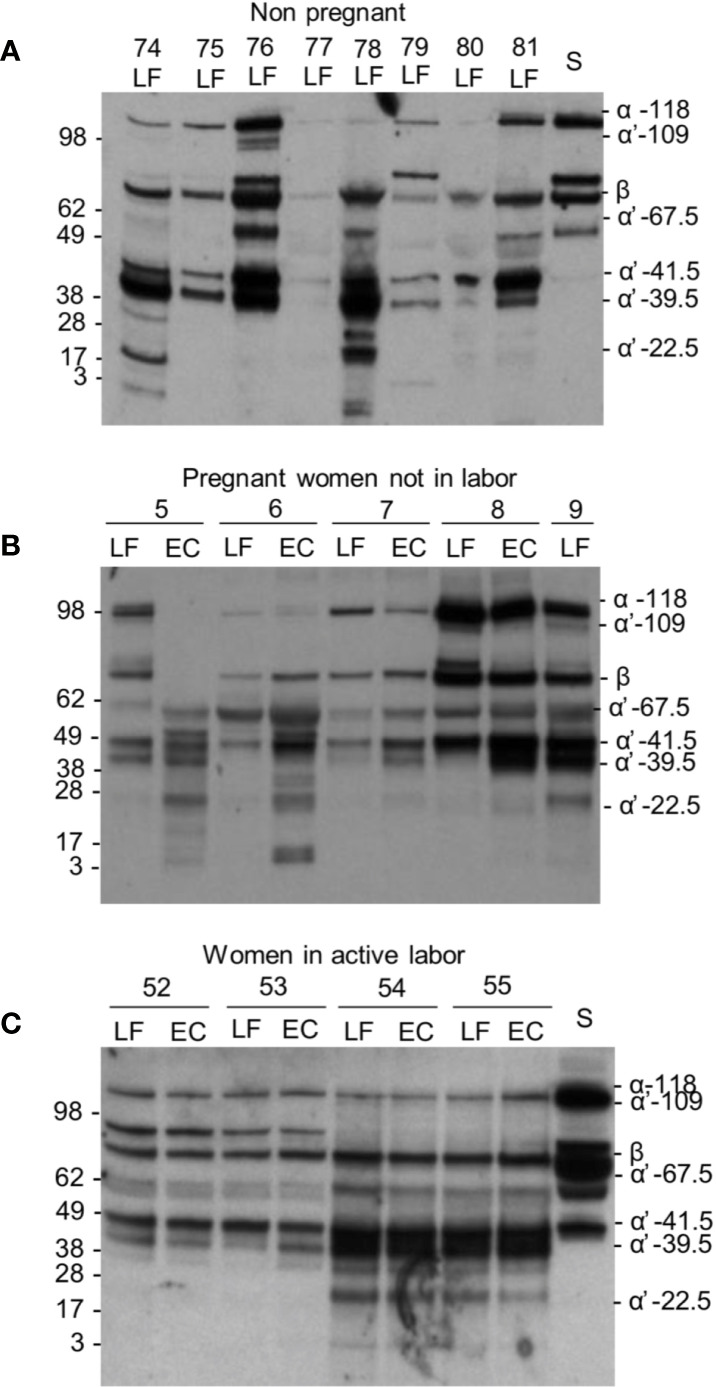
C3 cleavage in the cervicovaginal area. Examples from the three different sample groups are shown. Samples were from: (A) women in the nonpregnant group; (B) pregnant women, who are not in labor and (C) women in active labor but with intact membranes. The cleavage was studied by running the samples in SDS-PAGE under reducing conditions and using Western blotting with an anti-C3c antibody. Sample numbers and types within each group are indicated on the top of the blot. As shown, a wide variation in the extent of C3 cleavage occurs in the samples. The β chain and the key α´-chain fragments are indicated on the right. Molecular weight markers (kDa) are indicated on the left. S, serum control.